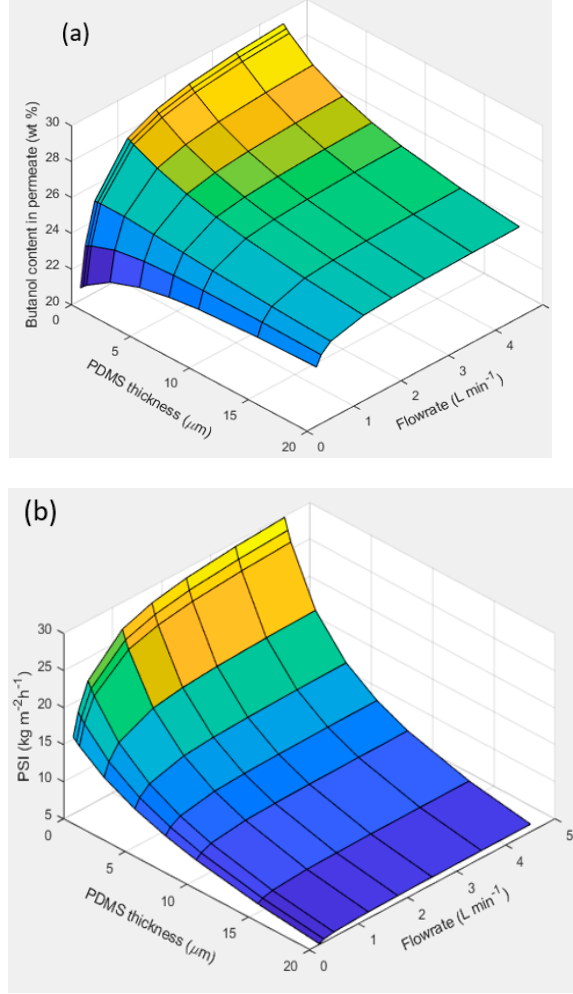
Figure 4. Simulation showing the influence of the feed flow rate and thickness of the PDMS dense layer on ( a ) butanol content in permeate (wt%) and ( b ) PSI, for a membrane module 1 m in length (operating conditions: 40 °C; downstream pressure: 10 mbar; feed mixture: (1:2:1 wt%) ABE solutions).